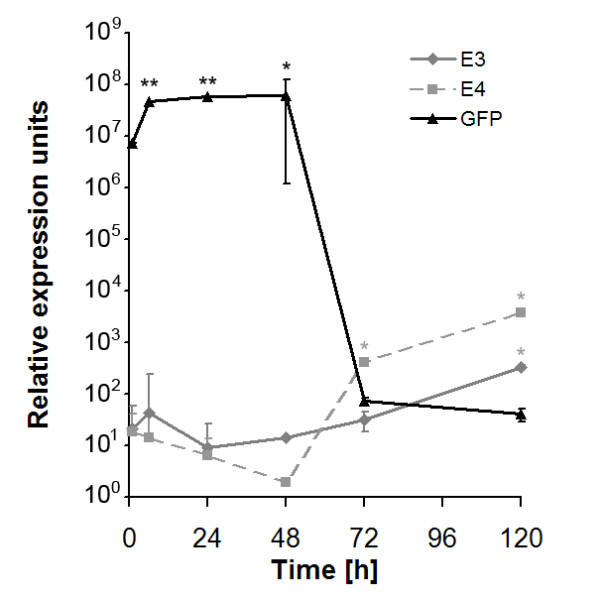
Adenoviral mRNA-expression in vivo. RT-PCR analysis of viral regions E3, E4 and transgene GFP expression in immunocompetent mice up to 120 h post transduction with 1010 IU Ad-GFP (* = p < 0.05, ** = p < 0.005). Data was normalised to 18S ribosomal RNA (ratio: target gene/housekeeping gene).